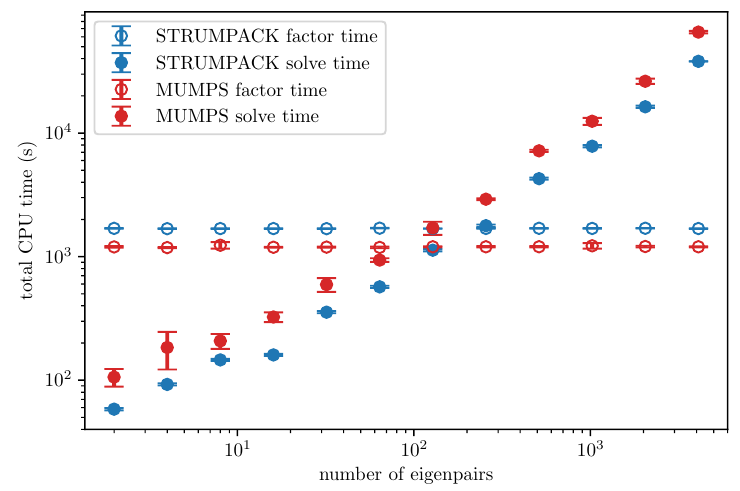
Figure 6: Time required for the computation versus number of eigenpairs requested, for the system of size L = 20, using the full MPI strategy. The execution times are averaged over 5